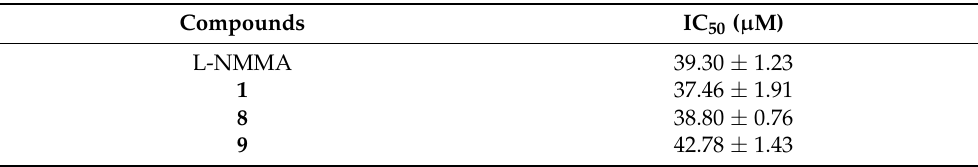
Table 4. Inhibitory activities of compounds 1 , 8 , and 9 on NO production by lipopolysaccharide- activated macrophage